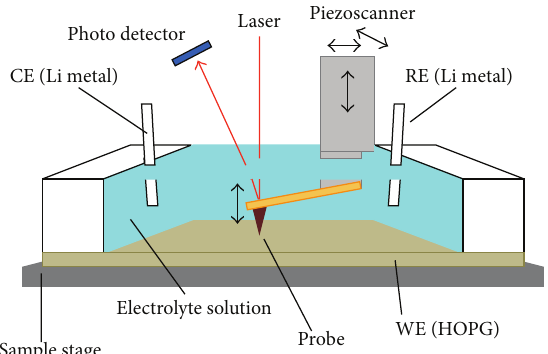
Figure 1: Schematic of electrochemical cell for in situ AFM obser-